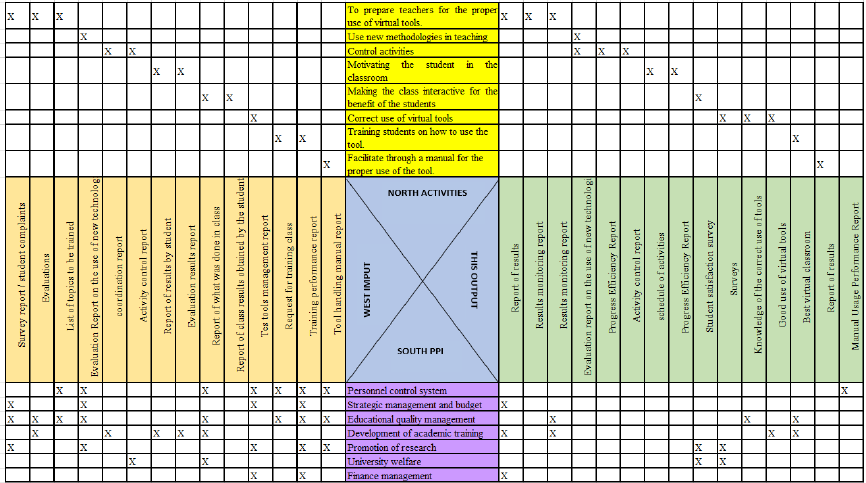
Fig. 17. Maltese Cross and its analysis by